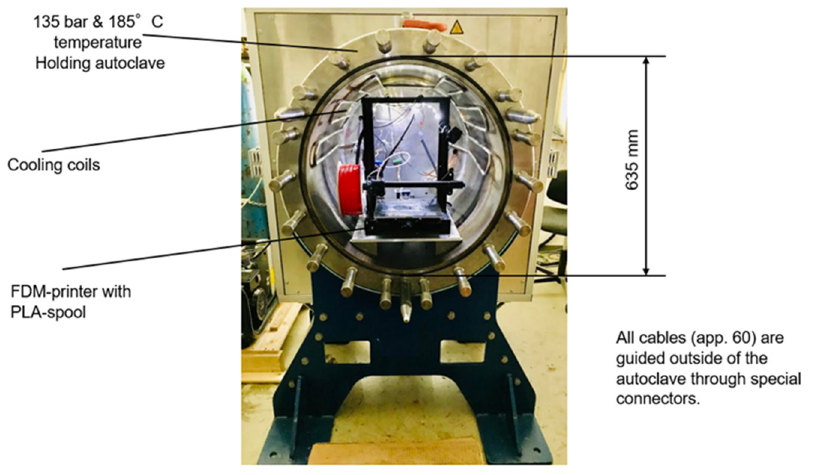
Figure 3. 3D printer Setup in Autoclave.